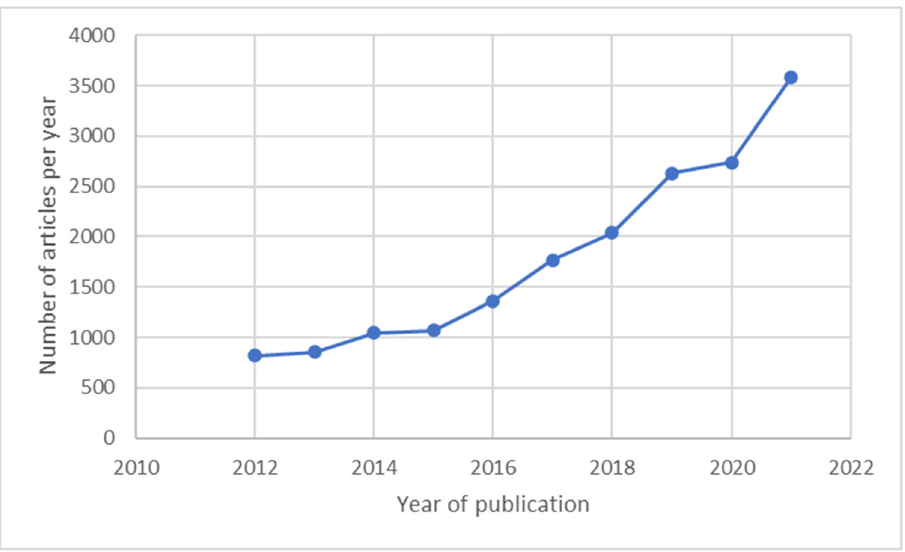
Figure 1. Number of papers on process design and sustainable development, Web of Science.